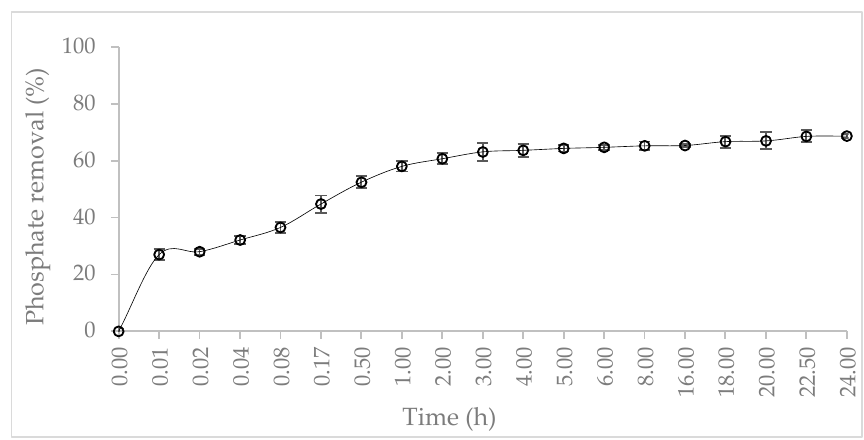
Figure 7. Phosphate removal profile onto Mn 2+ /Zn 2+ /Fe 3+ /Mg-Al-LDH as a function of time.